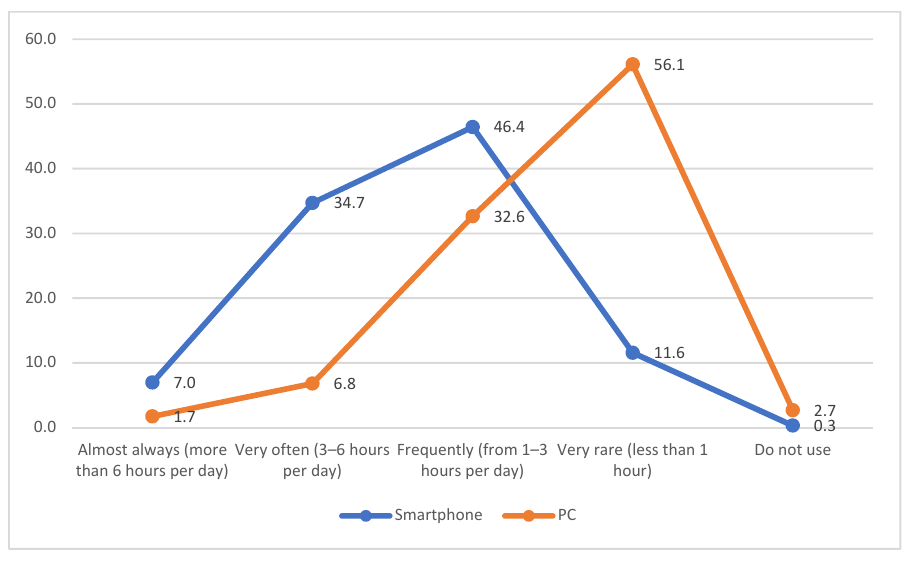
Figure 1. Exposure to internet.